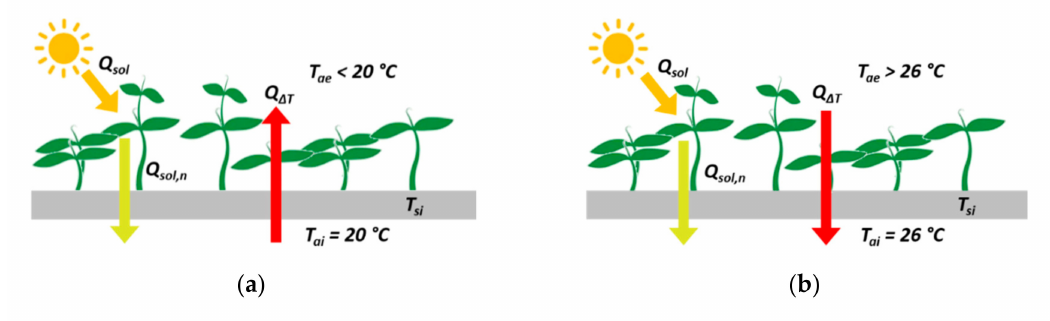
Figure 5. Schematic diagram of green roof during ( a ) heating season and ( b ) cooling